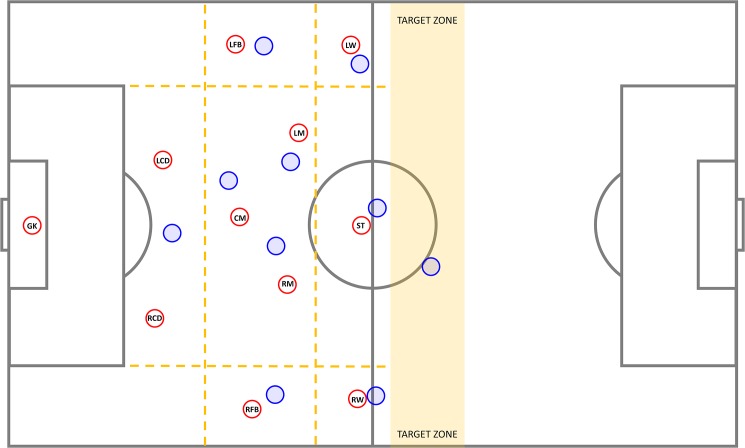
Schematic representation of the experimental task.